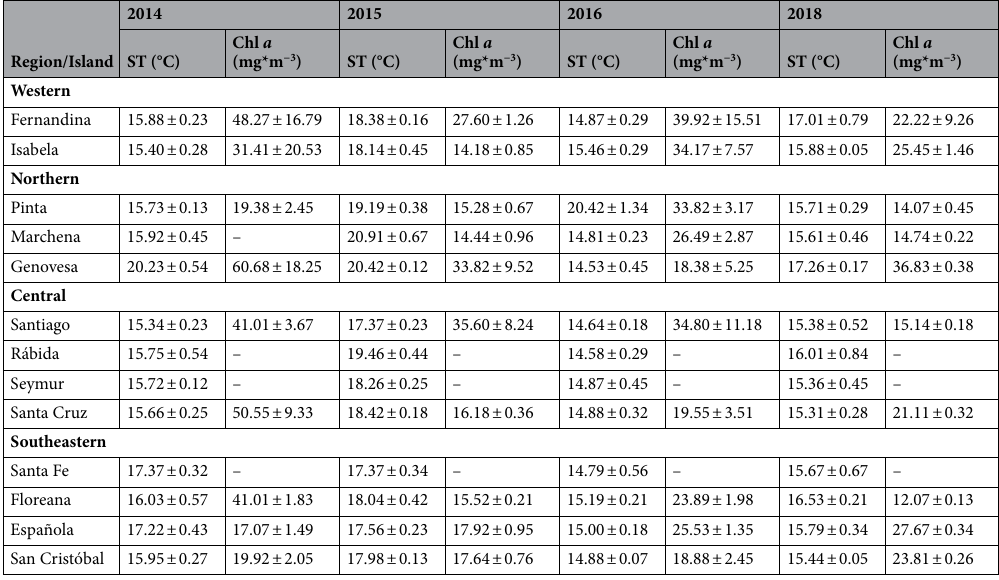
Table 4. Subthermocline temperature (ST, °C) and depth-integrated chlorophyll-a concentration (Chl a , mg*m −2 ) values (means ± SD), recorded in areas near the main rookeries of Galapagos sea lions and Galapagos fur seals between 2014–2018. *There are no available data for 2017.